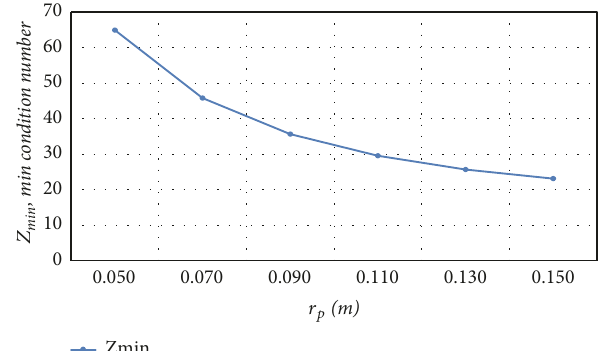
Figure 4: 𝑍 𝑚𝑖𝑛 (min condition number) variations for different 𝑟 𝑝 values while 𝑟 𝑏 is fixed to 0.175[m] .